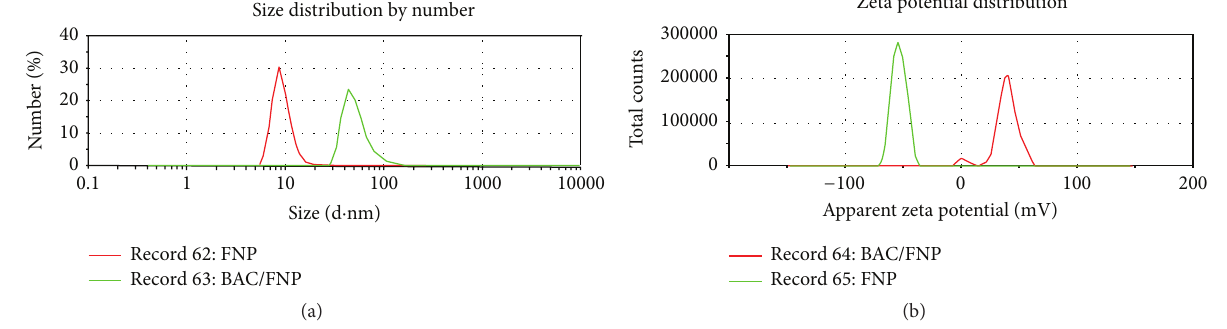
Figure 1: Size distributions by number (a) and zeta potentials (b) of fullerenol (FNP) and fullerenol/benzalkonium chloride (FNP/BAC) nanocomposite.